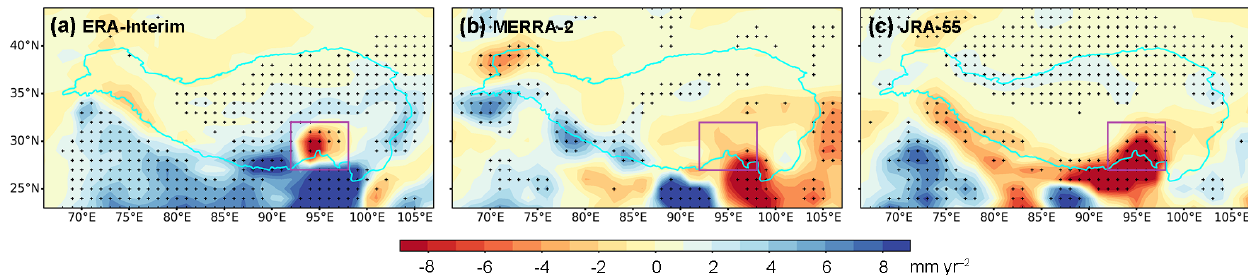
Figure 5. Long-term trends of oceanic moisture contribution to precipitation over the TP region on the annual scale using ( a ) ERA-Interim (1979–2015), ( b ) MERRA-2 (1980–2015) and ( c ) JRA-55 (1979–2015). Stippling indicates regions with statistically significant trends ( p< 0 . 05). The purple rectangle represents the